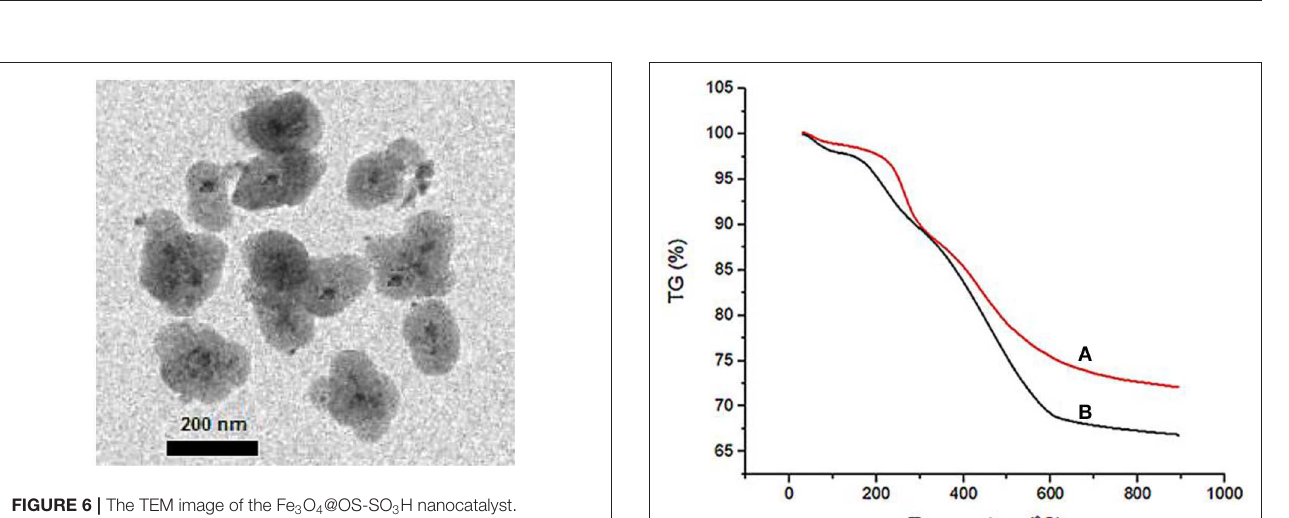
FIGURE 6 | The TEM image of the Fe 3 O 4 @OS-SO 3 H nanocatalyst.